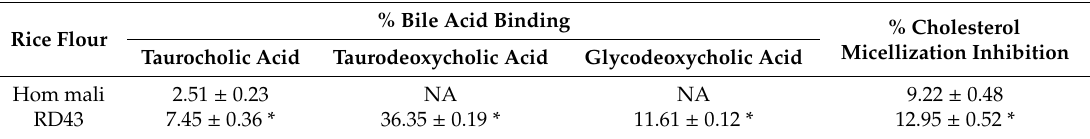
Table 2. Effects of Hom Mali and RD43 rice flour on bile acid binding and the inhibition of cholesterol micellization.